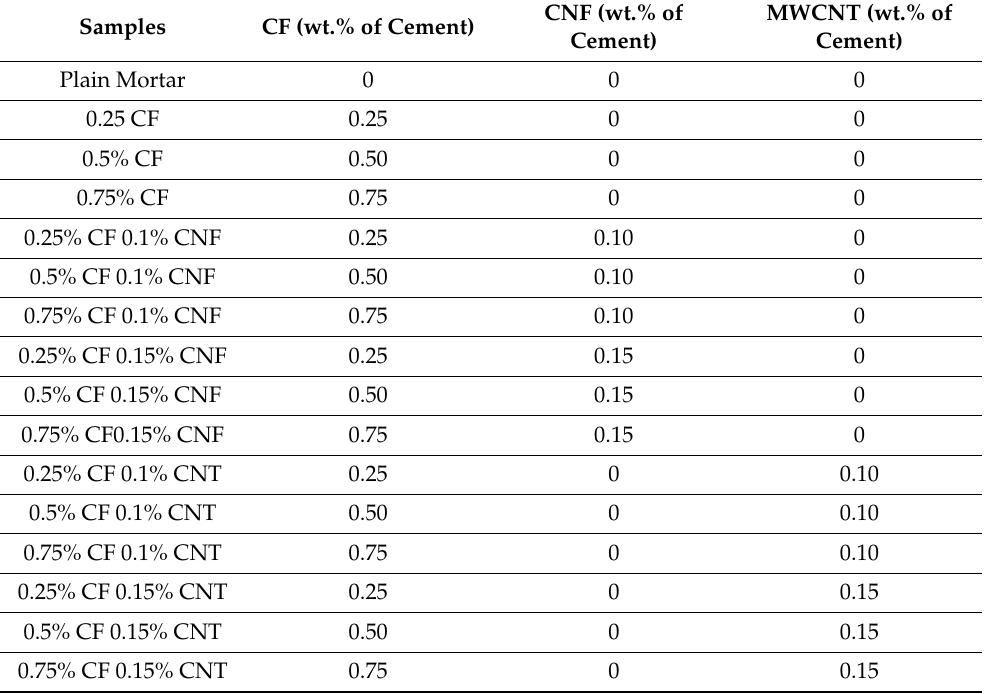
Figure 4. ( a ) Dimension of the dog bone samples. ( b ) Samples used for piezoresistive characterization. The molds were placed on a jolting machine for 30 s to remove the entrapped air. The molded samples were then covered by cellophane and placed in a chamber with a moist atmosphere for 24 h. The samples were demolded after 24 h and kept submerged in water for 28 days at 25 ◦ C. The samples were taken out 4 h before the test, wiped with a cotton cloth and kept at the room temperature prior to the piezoresistive characterization. The compositions of different samples prepared are listed in Table 3. Table 3. Composition of different samples prepared for piezoresistive characterization (each sample contains 900 g of